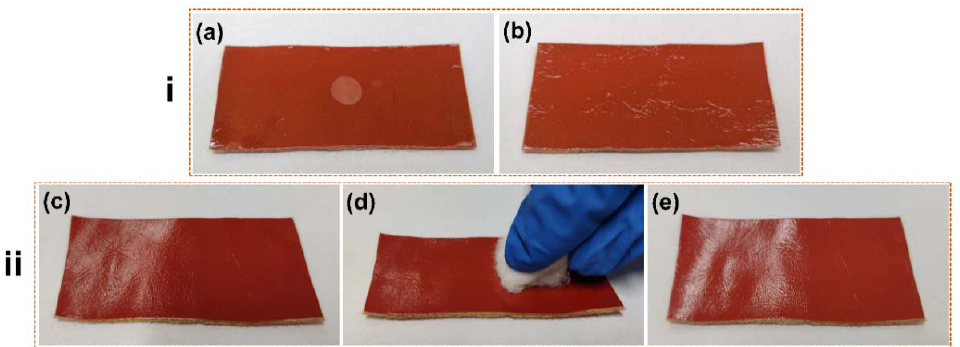
Figure 7. ( i ) Samples tested with isopropanol/water standard test solution: leathers coated with commercial C8 waterproofing agent ( a ) and FPU waterproofing agent ( b ); ( ii ) Solvent resistance test of the coating by hand wiping: ( c ) before wiping, ( d ) wiping action illustration, and ( e ) after wiping with the solvent.